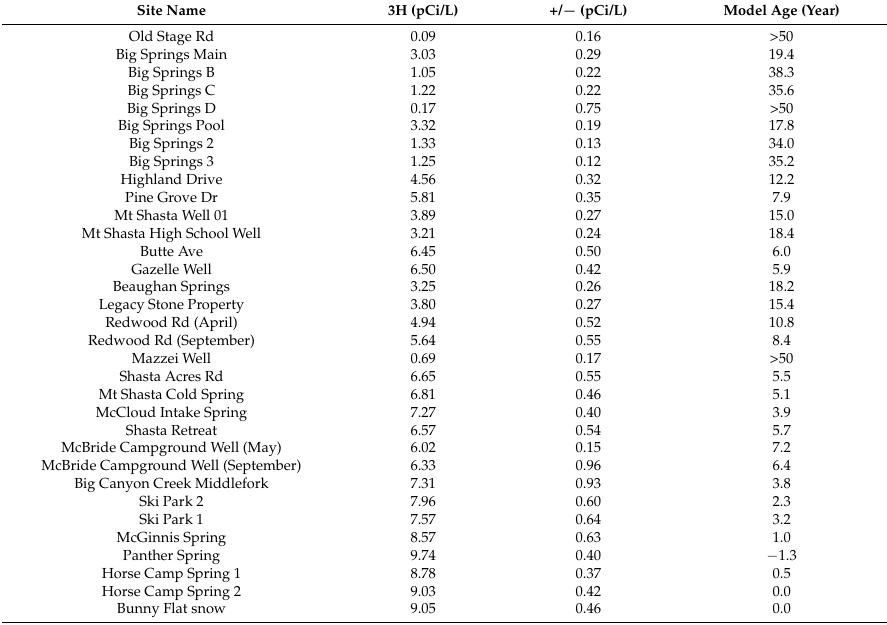
Table A5. Tritium and Model Age